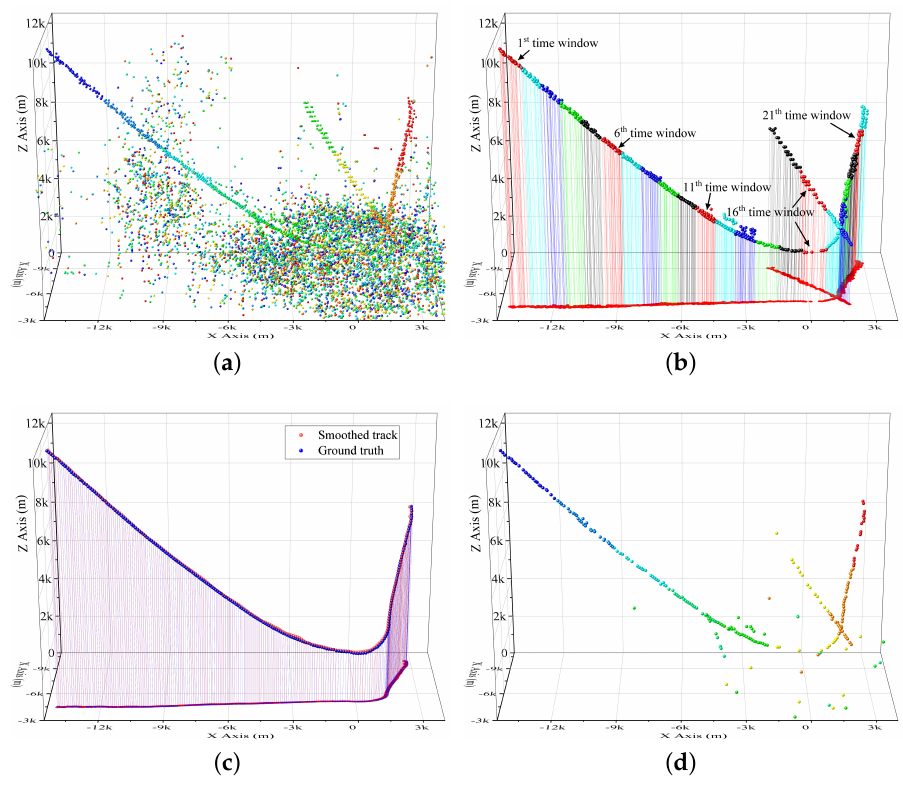
Figure 9. ( a ) The measurements in scenario 2 among 1 to 220 scans. ( b ) The tracklets obtained in 22 time windows. ( c ) The smoothed track and the ground truth. ( d ) The target position obtained by the ET-PHD filter